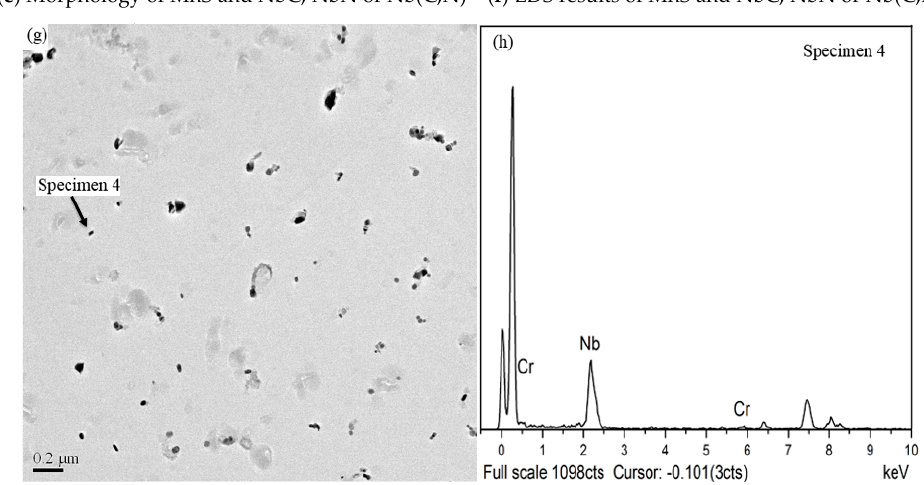
Figure 1. TEM/EDS results of typical precipitates in the specimens- (a)/ (b), (c)/ (d), (e)/ (f), (g)/(h). Figure 1. TEM / EDS results of typical precipitates in the specimens—( a – h